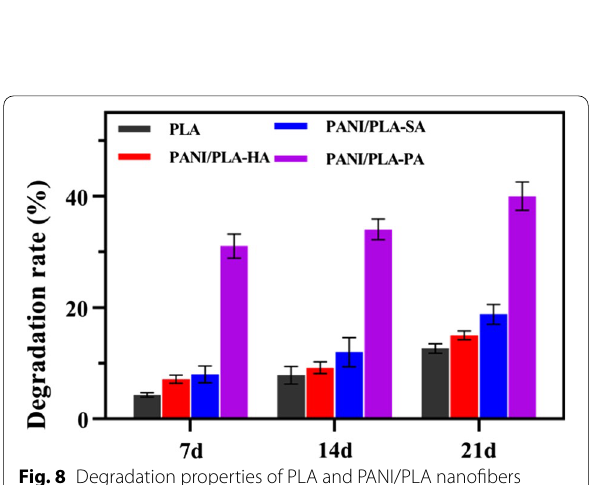
Fig. 8 Degradation properties of PLA and PANI/PLA nanofibers